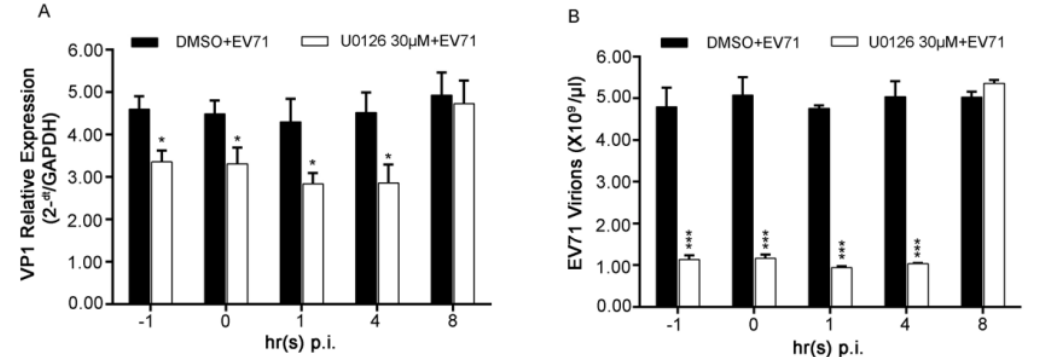
Figure 5. Effects of early ERK1/2 activation on EV71 infection in RD cells. ( A ) RD cells infected with EV71 at the MOI of 2 was treated with 30 μM of U0126 at the indicated time points p.i.. At 12 h p.i., cells were collected and viral VP1 gene among intracellular viral RNAs was quantified by relative qPCR; ( B ) The experiments were performed as described in panel A except 100 μg/mL of RNase A was used to eliminate naked viral RNAs before RNA was extracted. VP1 gene among intracellular EV71 virions was quantified by absolute qPCR. Data shown were the means ± SD ( n = 3). * p < 0.05 ** p < 0.01 *** p < 0.001, versus respective controls by Student’s t